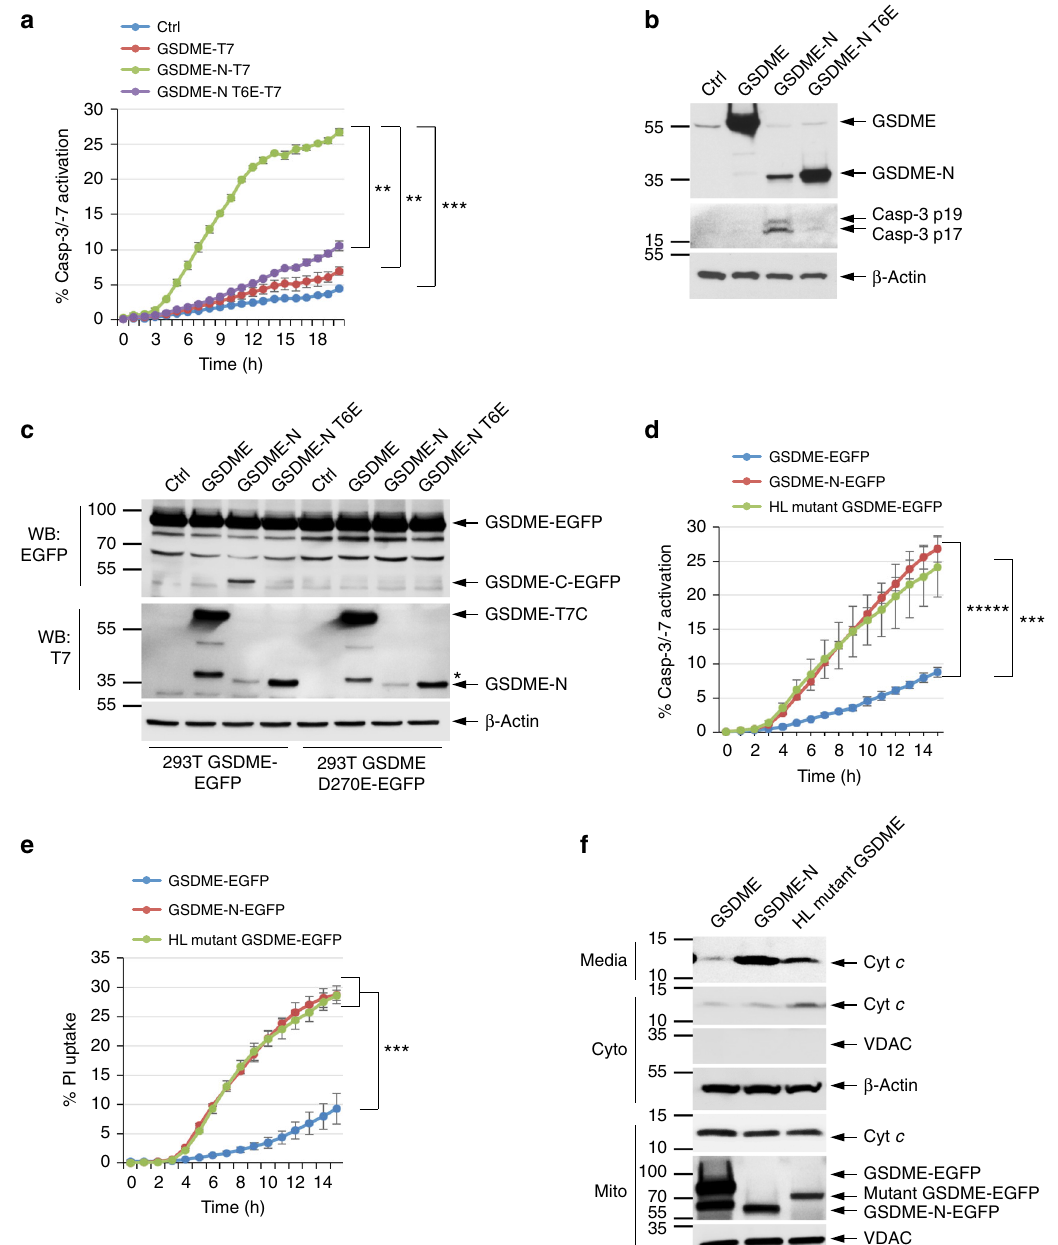
Fig. 7 GSDME functions as a feed-forward ampli fi er of caspase-3 activation and pyroptosis. a Active caspase-3 in 293T cells transfected with empty vector (Ctrl) or the indicated GSDME constructs as measured on the IncuCyte over time. b Immunoblots of lysates from 293T cells transfected with the